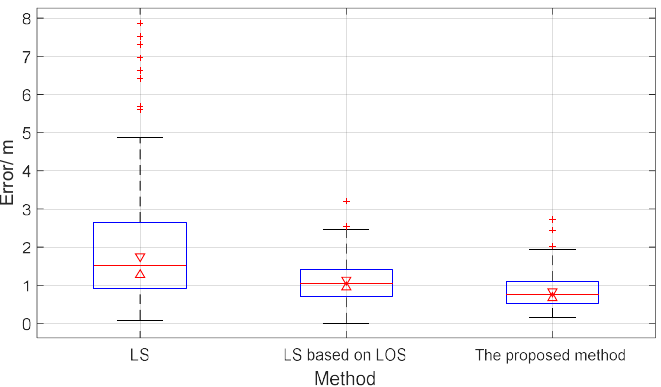
Figure 12. The positioning effects of LS, LS based on LOS, and the proposed method. Table 2. The statistical results of positioning errors of the three algorithms/m.